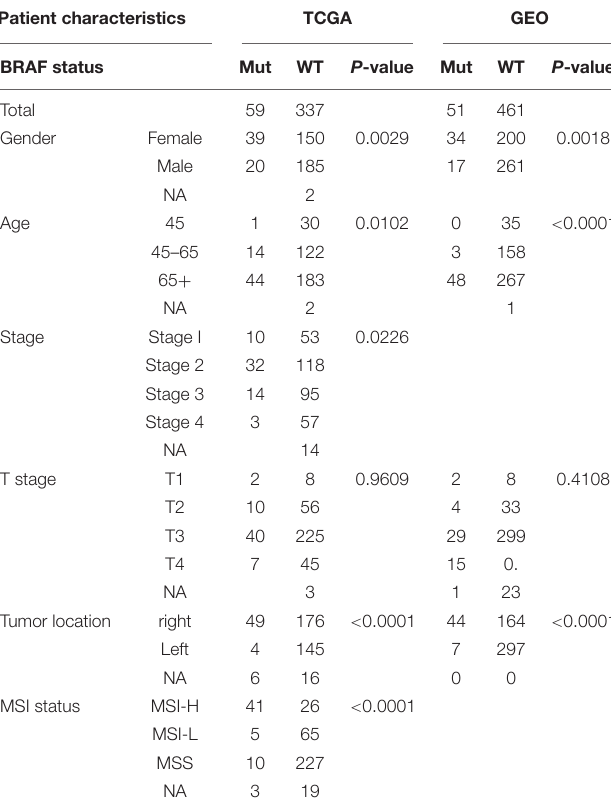
TABLE 1 | Patient characteristics in the TCGA and GEO